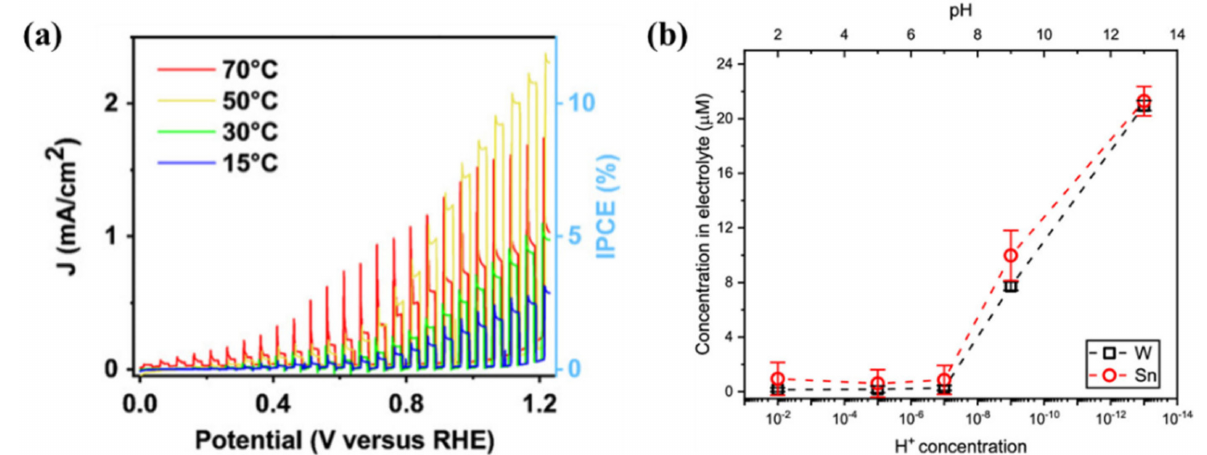
Figure 6. ( a ) LSV curves of the SnWO 4 (500 ◦ C H 2 ) photoanode measured in KOH/H 3 BO 3 buffer (pH = 9) with 0.2M Na 2 SO 3 at different temperatures under the chopped 455nm LED illumina- tion [55]; ( b ) the concentrations of Sn and W dissolved from α -SnWO 4 films after photoelectrochemi- cally treated at various pH levels at a potential of 1.23 V vs. RHE, for a total of 1 h